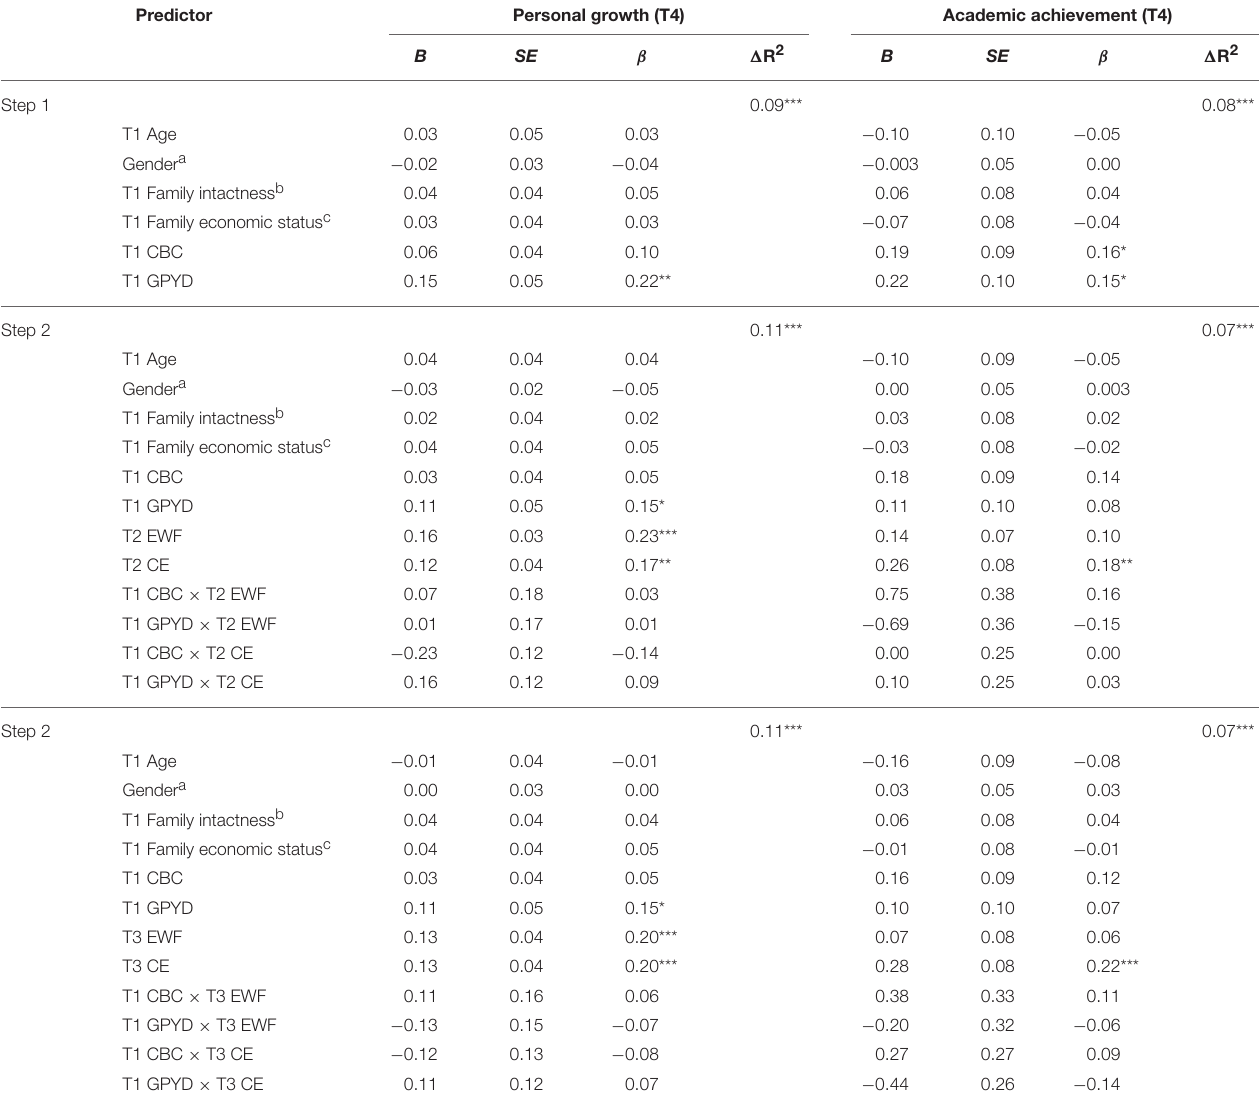
TABLE 4 | Regression analyses on personal growth and academic achievement at Time 4 ( N = 425–427). Predictor Personal growth